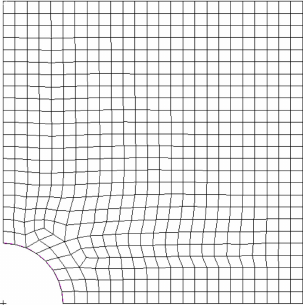
Figure 11. Discretization of FEM and radial point interpolation method (RPIM) with node interval h = 0.2.